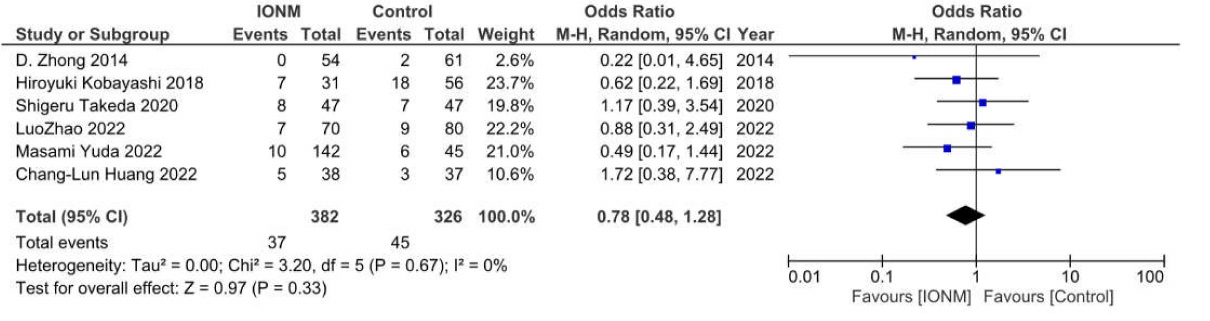
Figure 7. Forest plot of IONM for anastomotic leakage. Abbreviations: IONM— intraoperative neuromonitoring.